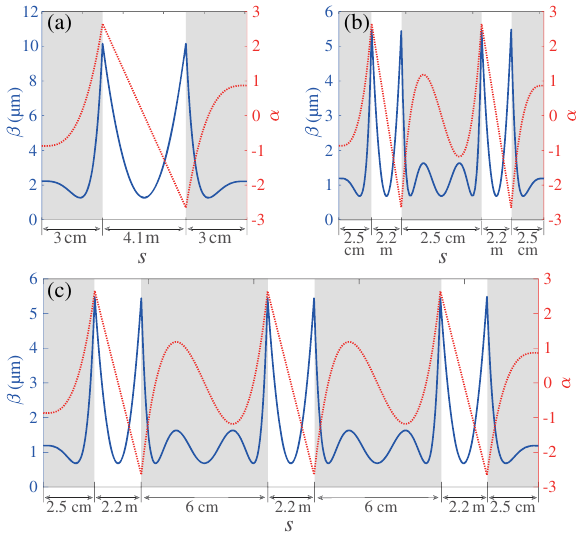
FIG. 13. Matched longitudinal Twiss of three typical arcs. The Twiss functions inside every dipole are their IT. (a) DBA; (b) TBA; (c) MBA. The x -axis represents the longitudinal position along this section. To show the details inside the dipole (with gray back- ground), the location of the dipole is zoomed in and adopts a unit of centimeter. For the separation between dipoles (without back- ground), where β changes quadratically, the x -axis unit is meter. In each element, the scale of the x -axis is